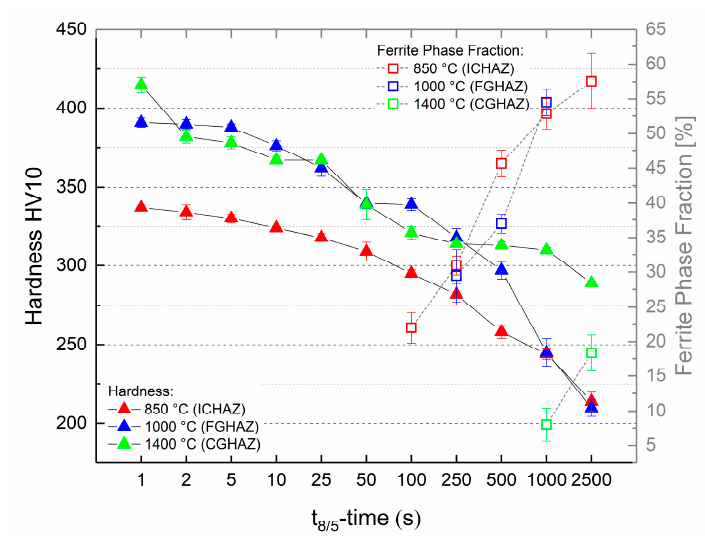
Figure 12. Vickers hardness and ferrite phase fraction as a function of the t 8 / 5 -times for the dilatometers specimens of the all-weld metal’s CGHAZ, FGHAZ and ICHAZ CCT